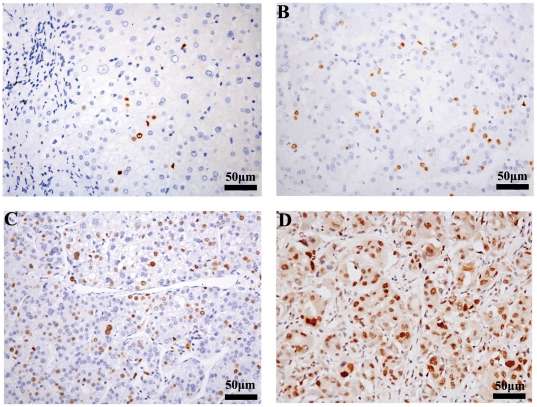
Immunohistochemistry for CENP-A in HCC and adjacent nontumor liver tissues.Representative CENP-A staining in (A) nontumorous liver tissue, and in (B) well-differentiated, (C) moderately-differentiated, and (D) poorly-differentiated HCC. The CENP-A staining is predominantly nuclear in the samples examined, with concurrent diffuse cytoplasmic staining in poorly-differentiated HCC.